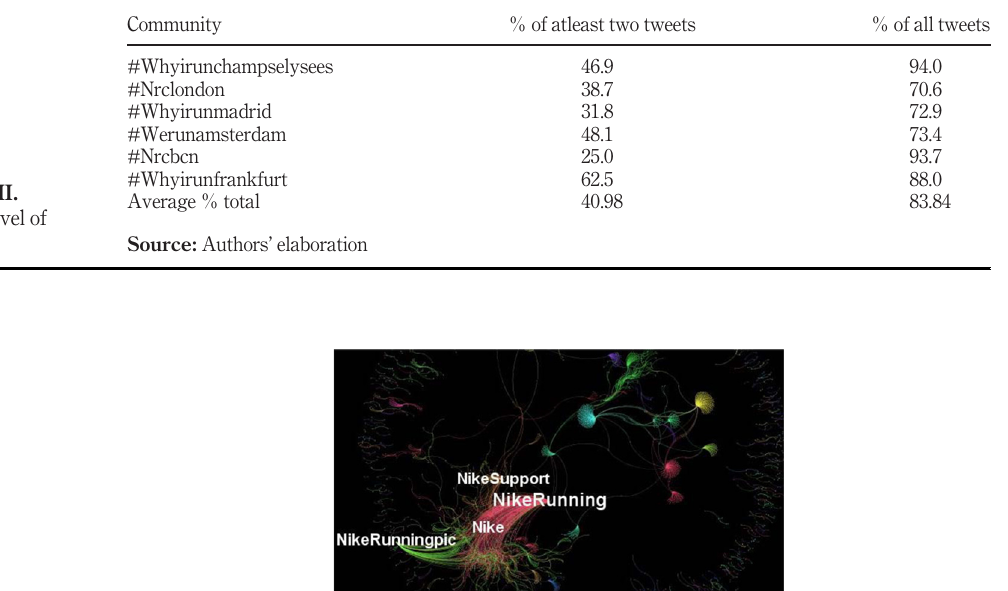
Figure 1. An exemplary social network